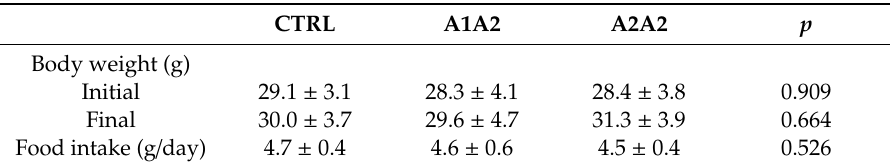
Table 2. Body weight and food consumption from CTRL, A1A2 or A2A2 mice.